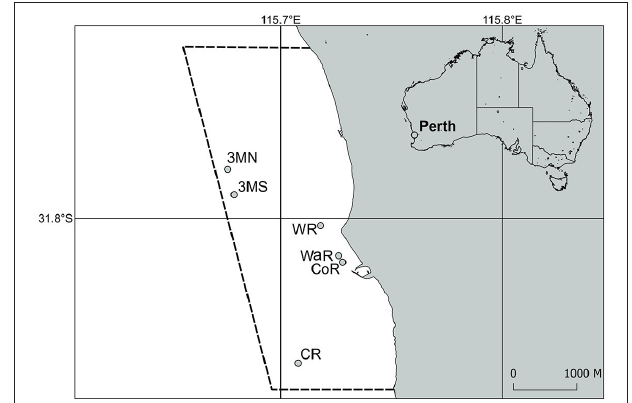
FIGURE 1 | Sample region and sites within Marmion Marine Park off of Perth, Western Australia. The dashed lines indicate the boundary of the marine park. 3MN, Three Mile Reef North; 3MS, Three Mile Reef South; WR, Wreck Rock; WaR, Wanneroo Reef; CoR, Cow Rocks; CR, Centaur Reef.